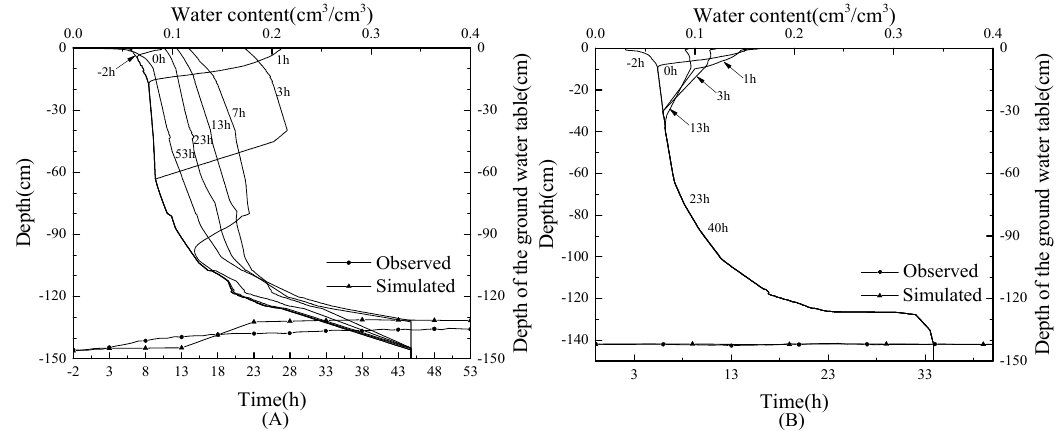
Figure 9. Variations of water content and water table after two different rainfalls. Description of the water content profile and water table time-series before, during, and after rainfall, see text for further information. ( A ) the rainfall at 06:00 on 20 September 20 2014 and ( B ) the rainfall at 20:00 on 9 August. A recharge front was defined as the interface between the rising zone and the unchanged zone of water content, above which water content rose and below which water content remain